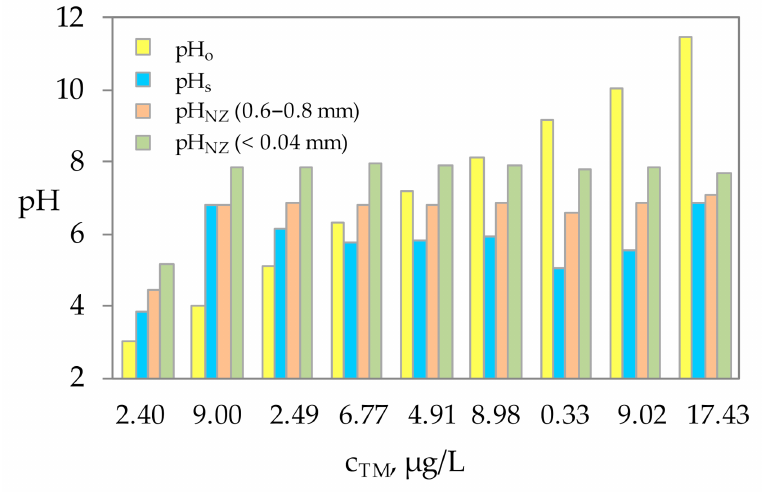
Figure 12. The comparison of pH values before leaching (pH o ), prior to sorption (pH S ) and after sorption (pH NZ ) on two particle sizes of natural zeolite.